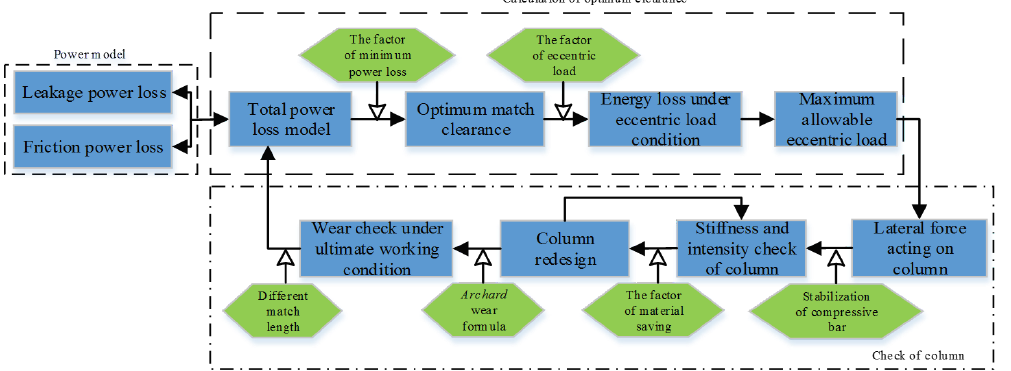
Figure 3. Optimization flow of guidance for slide and pillar of hydraulic press.